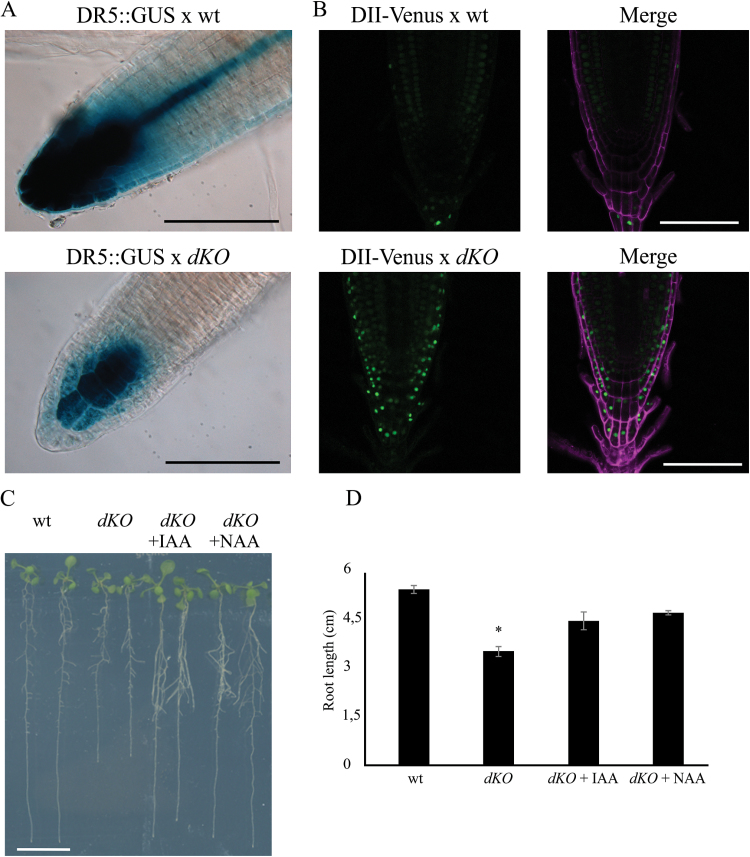
Auxin distribution is altered in the root meristem of the dKO. (A) GUS expression pattern of DR5:GUS in dKO background (lower panel) is weaker than in DR5:GUS (upper panel). Scale bar = 100 μm. (B) The green fluorescence of DII-Venus shows much higher levels in the dKO background (lower panel) compared with the wild-type (upper panel), in particular in the columella cells and in the epidermis. Venus Ex: 488nm, Em: 520–540nm; PI Ex: 488nm, Em: 600–650nm. Scale bar = 100 μm. (C) dKO short-root phenotype is rescued by application of 10nM IAA or NAA to 5-d-old seedlings and analysed after 5 d. Scale bar = 1cm. (D) Quantification of the primary root length of wild-type and dKO lines under control condition or upon auxin treatment (*P<0.01, Student’s t-test). (A colour version of this figure is available at JXB online.)